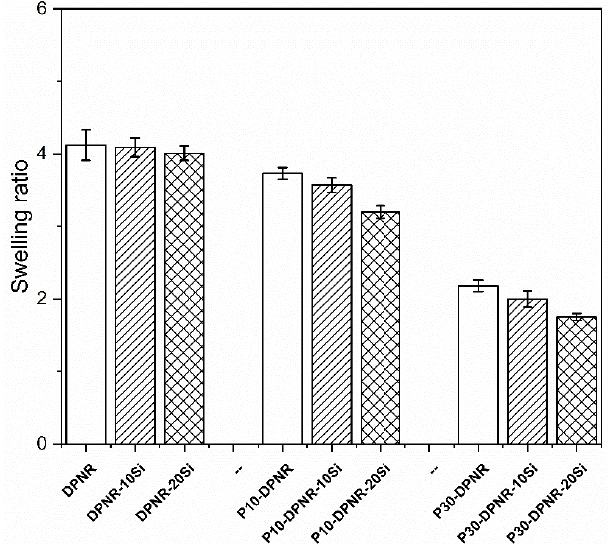
Figure 9. Swelling ratio of the silica-filled natural rubber composites.